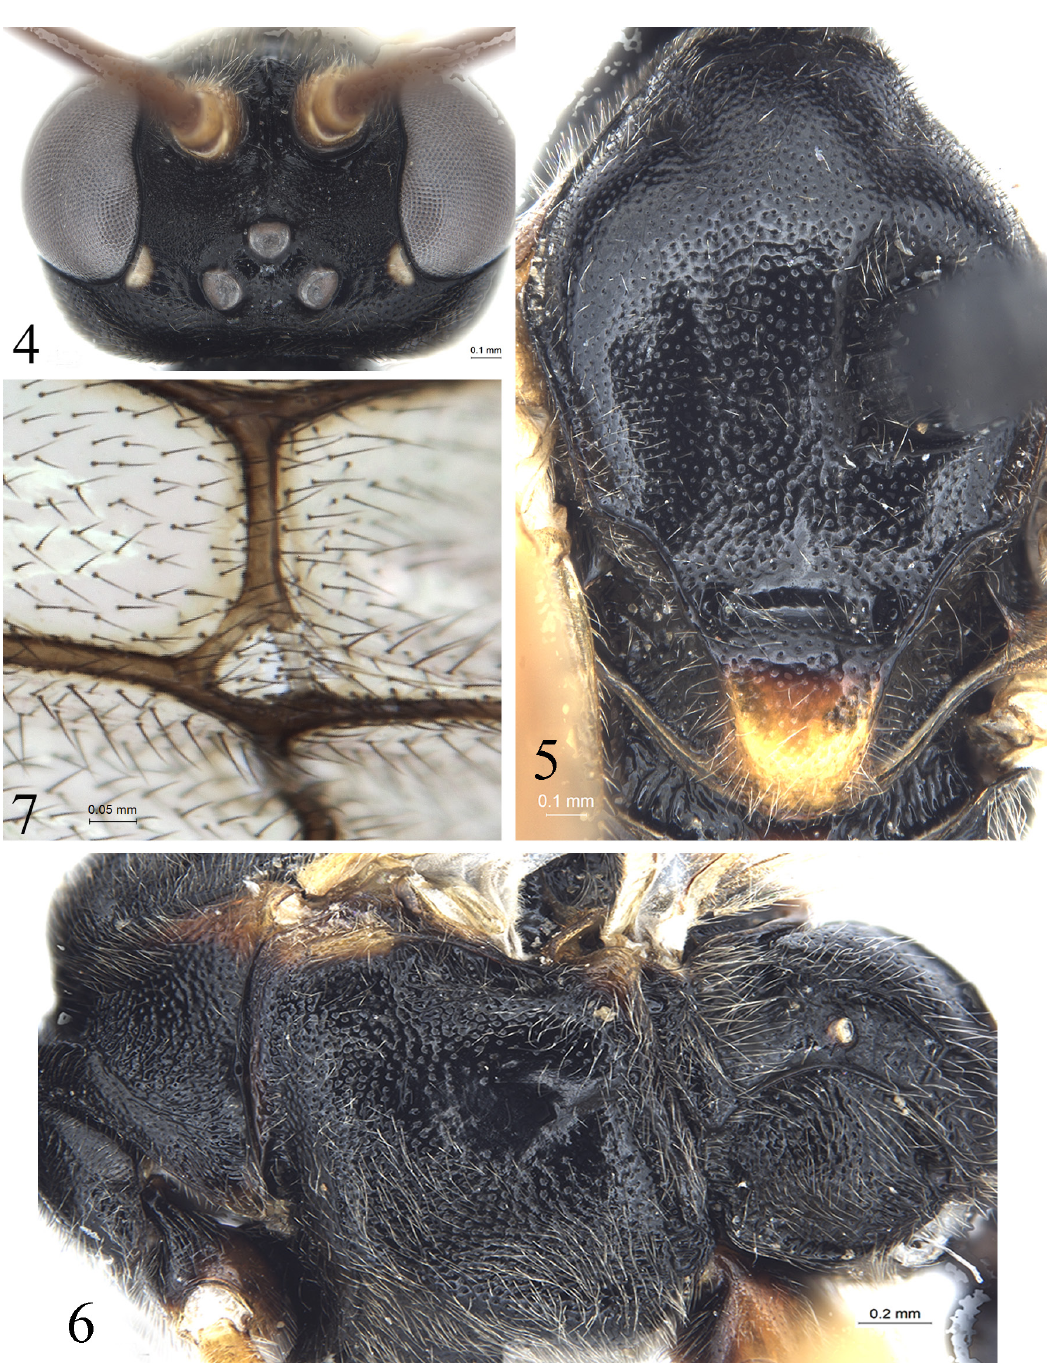
M esosoMa . Anterior margin of pronotum with dense fine punctures, lateral concavity shallow, wide, with irregular short wrinkles; upper-posterior portion almost shiny, with distinct, fine punctures. Mesoscutum (Fig. 5) smooth, shiny, with relative dense punctures, distance between punctures 0.2–2.5 × diameter of puncture, denser on posteriormedian portion. Anterior portion of notaulus present. Scutoscutellar groove relatively shallow, smooth. Scutellum with fine punctures, posterior portion with relative long